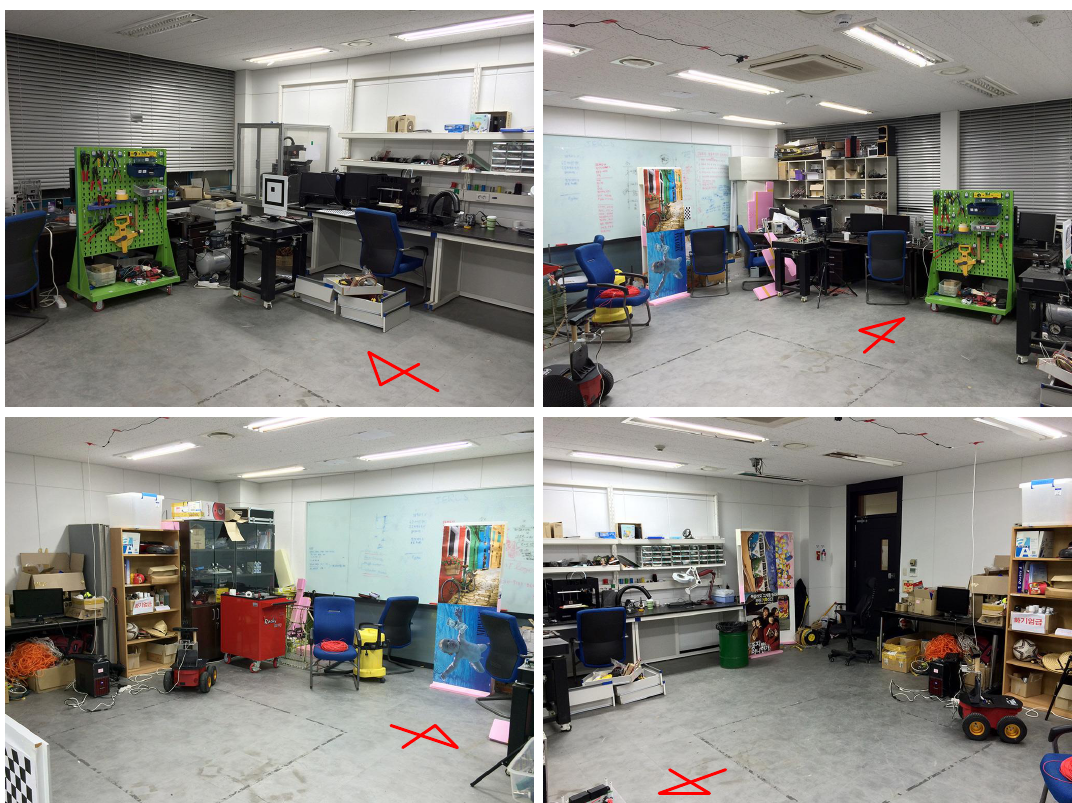
Figure 16. Experimental site used for low dynamic